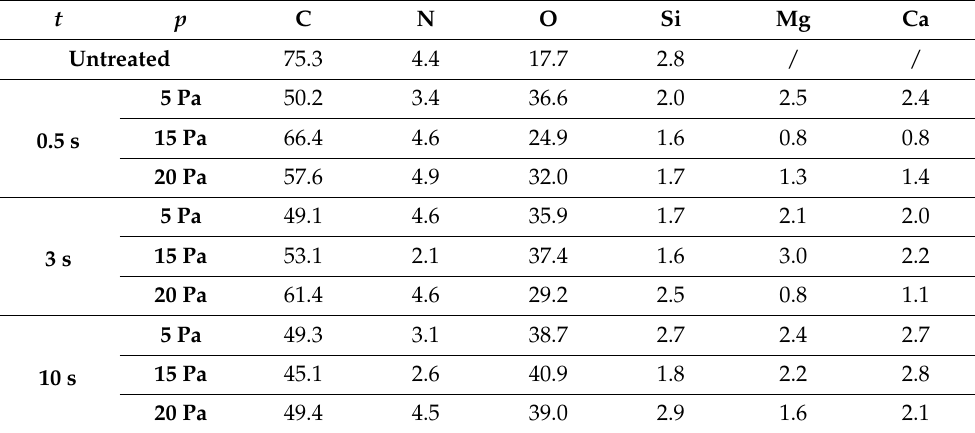
Table 1. Elemental composition of native and plasma-treated bean seed surface expressed in at.%. Excluded are elements appearing in only a few analyses, mainly in amounts < 1 at.% (K, S, Al, P, F, and